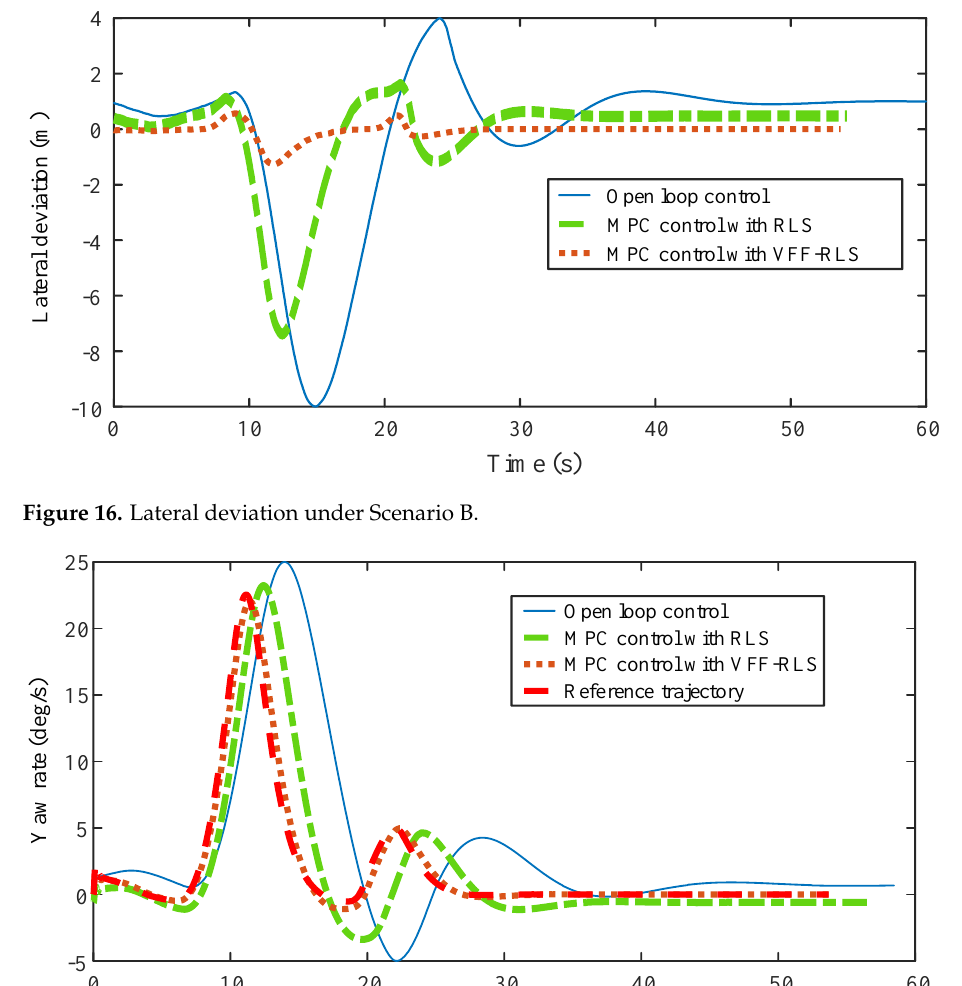
Figure 15. Steering wheel angle under Scenario B.